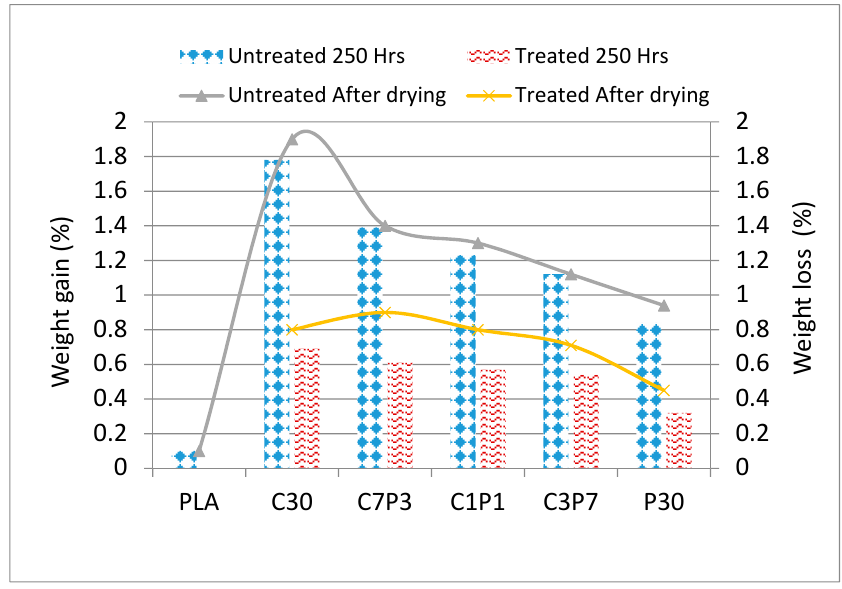
Figure 1. Change in weight over time for CF/PALF/PLA biocomposites, hybrid biocomposites, and PLA.